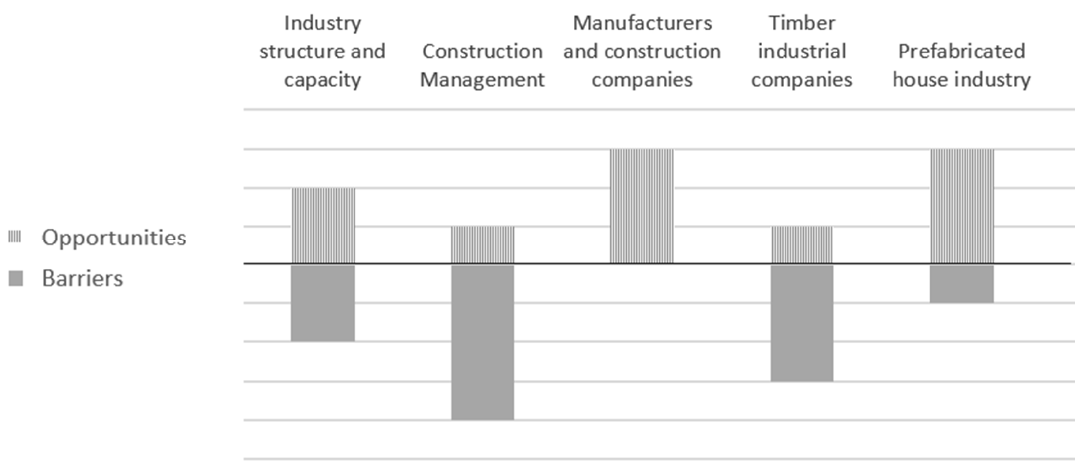
Figure 6. Relation of opportunities and barriers corresponding to the sub-codes allocated in each code of the category Production and Assembly .